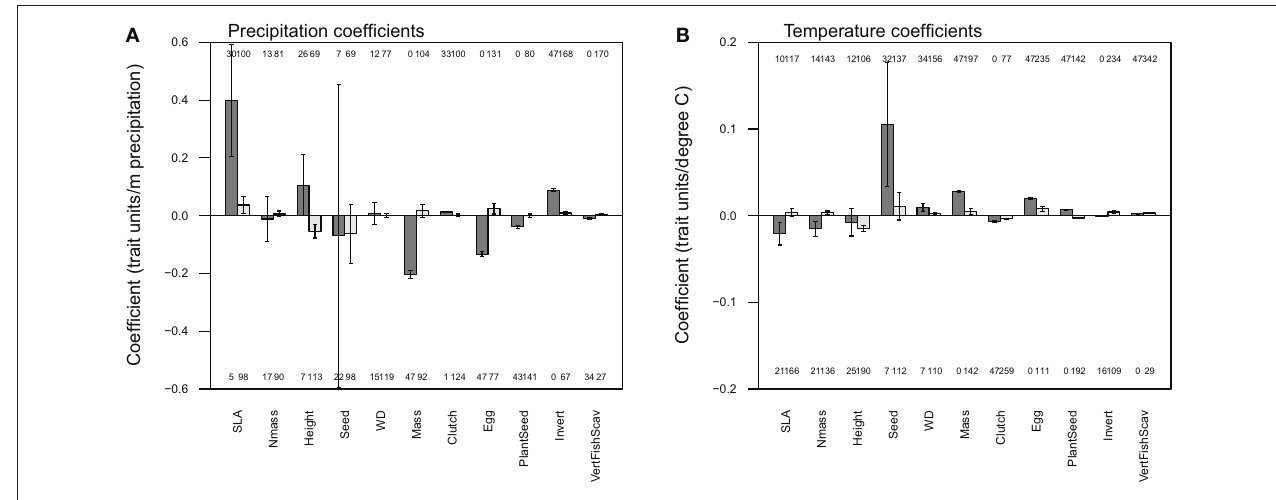
FIGURE 1 | Mean regression coefficients relating precipitation (A) and temperature (B) to each of eleven functional traits. For each pair of bars, the left (dark) bar indicates the mean spatial coefficient and the right (light) bar the mean temporal coefficient. The error bars indicate the 95% confidence interval. Each bar aggregates the coefficients across years (for the spatial models) or grid cells (for the temporal models). The number of individually significant years or grid cells is shown above (for positive) or below (for negative) the bars.